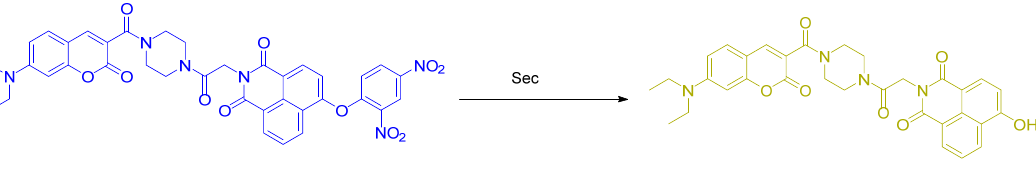
Figure 22. FRET probe CmNp–Sec by Zhao et al.